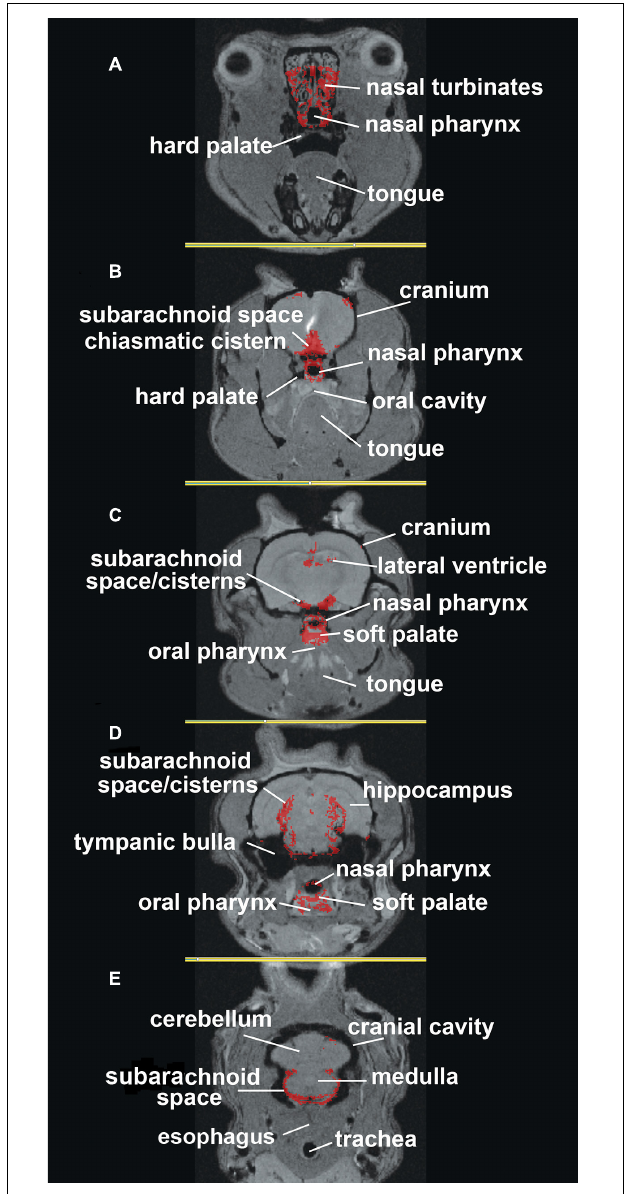
FIGURE 2 | Mapping ferumoxytol signal. Shown are axial sections (A–E) depicting the localization of the average CA signal from six rats mapped onto T2 weighted anatomy images of the rat